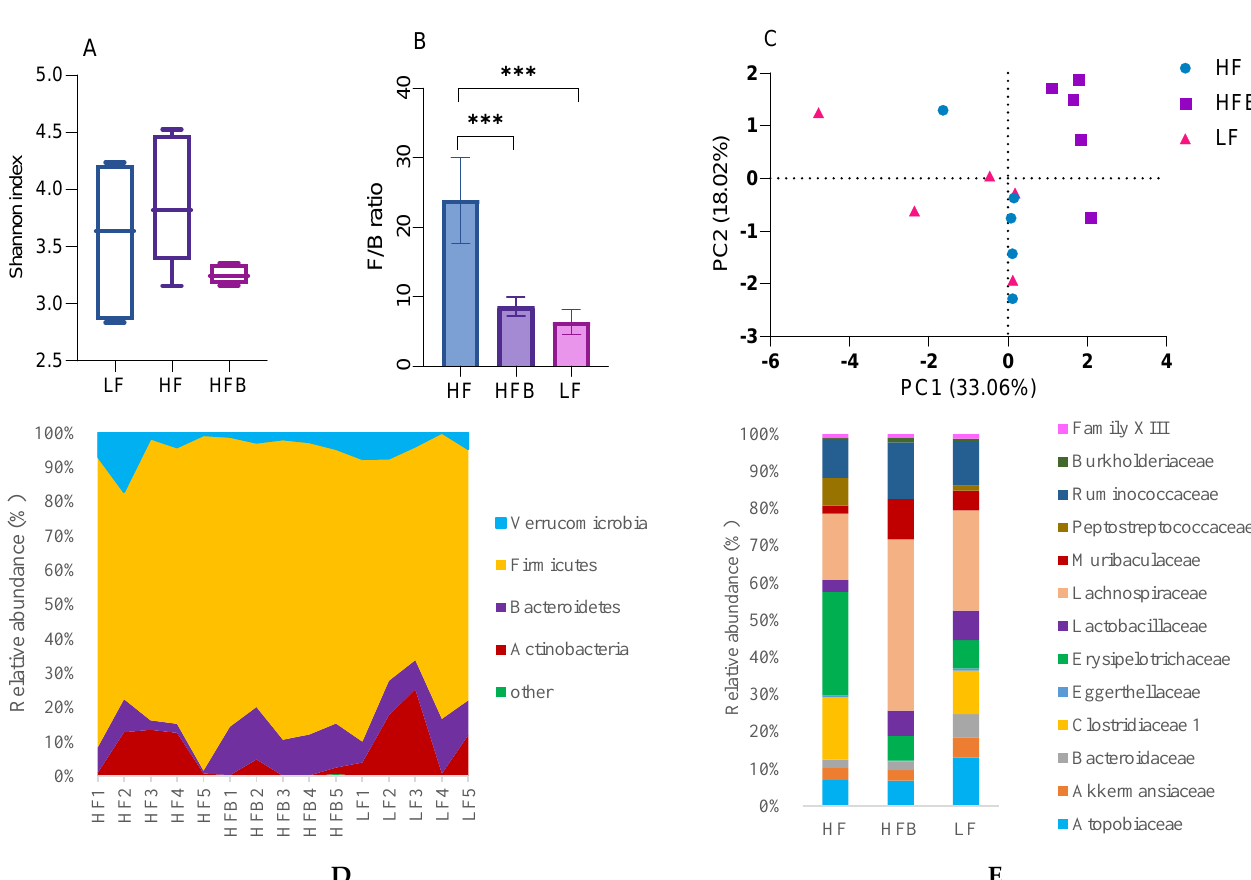
Figure 4. Box plots of ( A ) Shannon Index and ( B ) the ratio of Firmicutes to Bacteroidetes in mice fed each diet for 6 weeks, and ( C ) principal co-ordinate analysis (PCoA) plot of cecal microbial community data ( D ) the relative abundance of cecal microbiota at the Phylum level, and ( E ) the relative abundance of cecal microbiota at the Family level. *** p < 0.001 between groups.